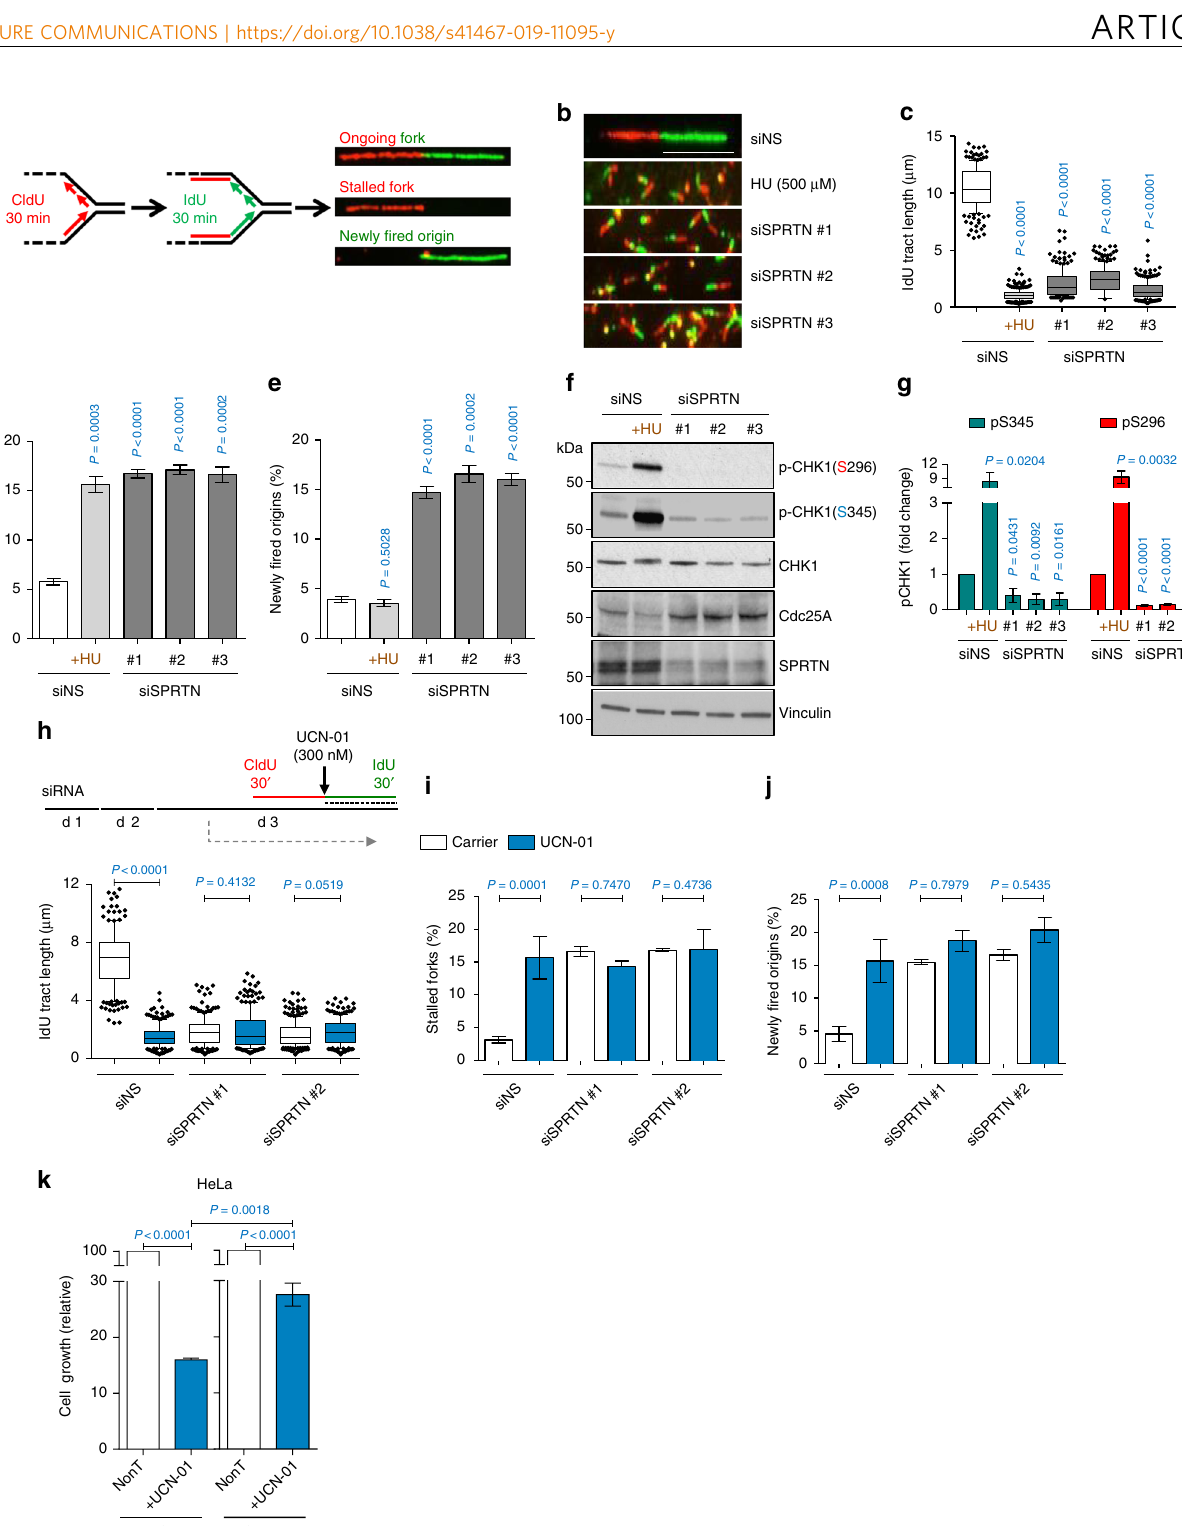
CHK1 auto-phosphorylates once its kinase activity has been sti- mulated by ATR 44,45 . Furthermore, despite being in similar cell cycle stages (Supplementary Fig. 1a – c), SPRTN-depleted cells exhibited less CHK1-S296 and -S345 phosphorylation than even unchallenged control cells and ∼ 9 – 10-fold less than HU-treated control cells, which showed similarly reduced replication fork velocity and elevated levels of fork stalling as SPRTN-depleted cells (Fig. 1f, g). Similar fi ndings were observed in HeLa cells (see